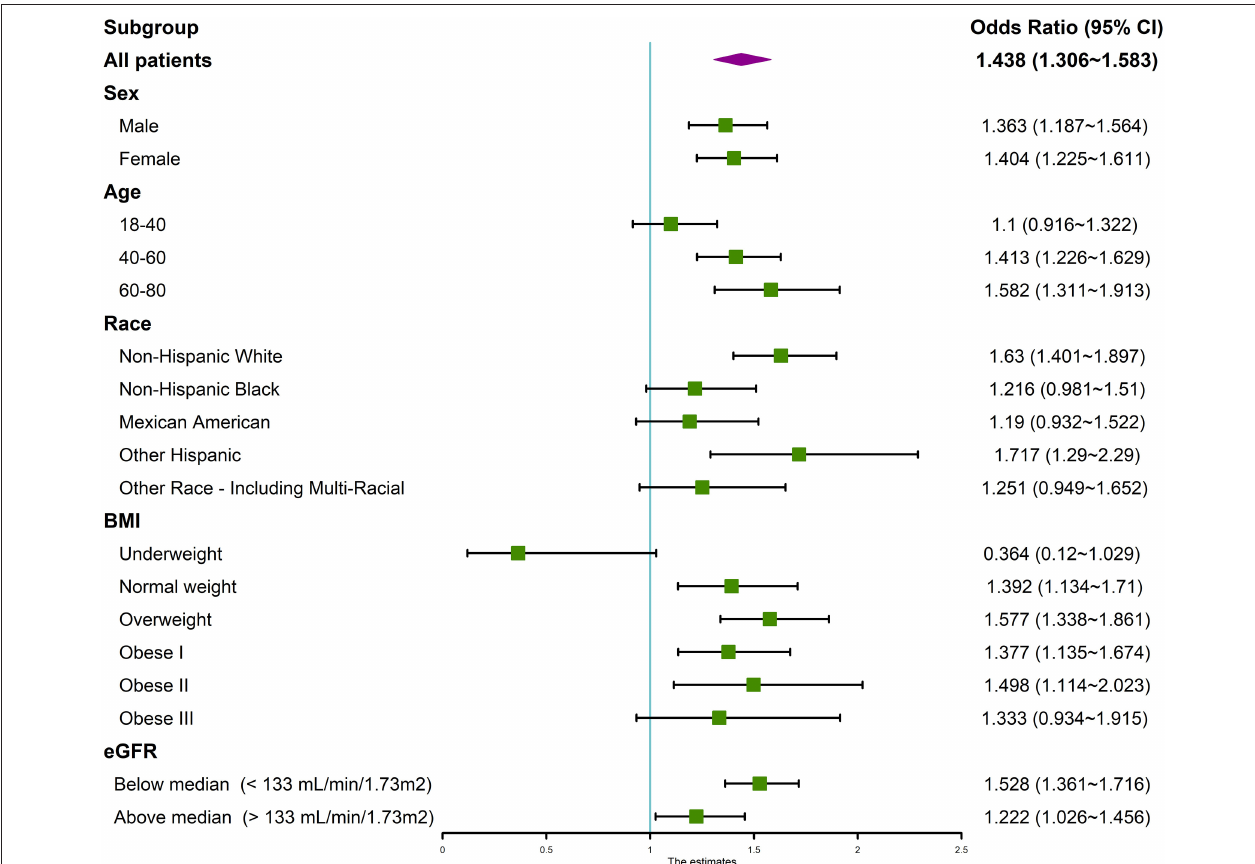
FIGURE 3 | Forest plot of subgroup analysis of the association between serum calcium and hypertension. We used the ORs to evaluate the association between per 1 mg/dl increase in serum calcium with the prevalence of hypertension in the subgroup of sex, age, race, BMI, and eGFR. The association between serum calcium and hypertension remained significant across categories. The association was adjusted for age, gender, race/ethnicity, education levels, BMI, diabetes history, smoking status, alcohol consumption, sodium intake, triglycerides, total cholesterol levels, albumin, eGFR, and serum phosphorus. OR, odds ratio; CI, confidence intervals.